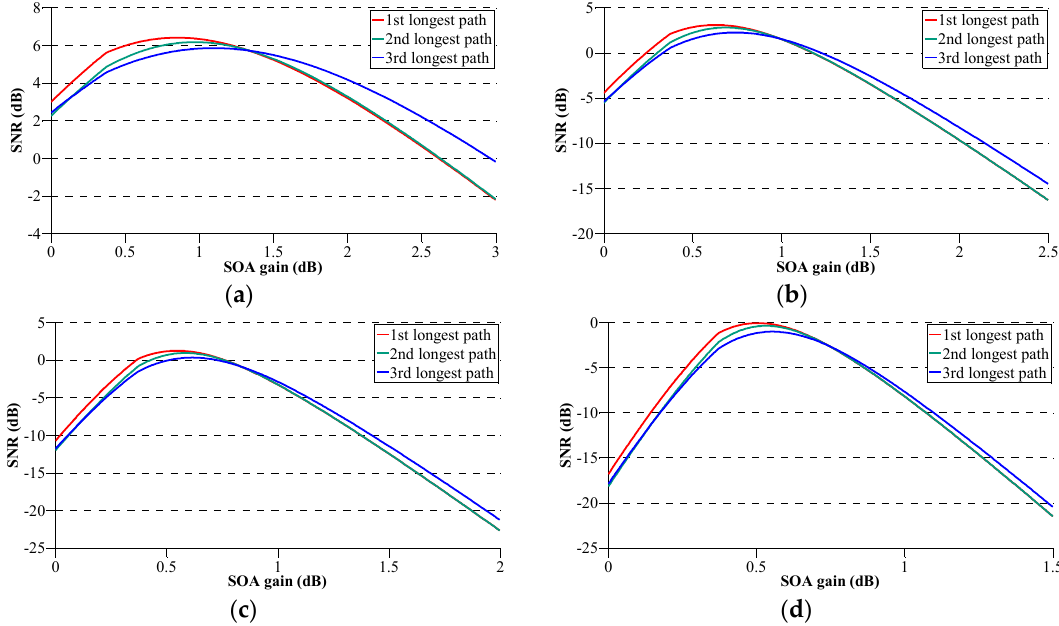
Figure 11. Worst-case SNR for SOA-enabled HONoC according to the SOA gain for different network sizes: ( a ) 8 × 8; ( b ) 16 × 16; ( c ) 24 × 24; and ( d ) 32 × 32.